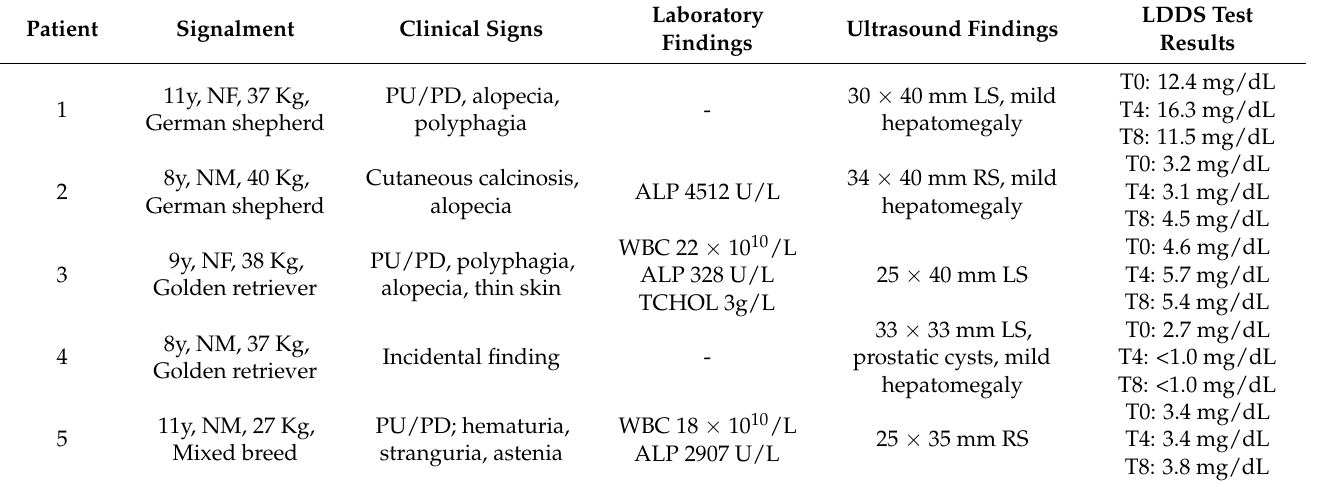
Table 1. The signalment, clinical and laboratory findings, ultrasound size of the left side (LS) and right-side adrenal tumors (AT), and other ultrasound abnormalities of the dogs included in the study and LDDS test results presented in the